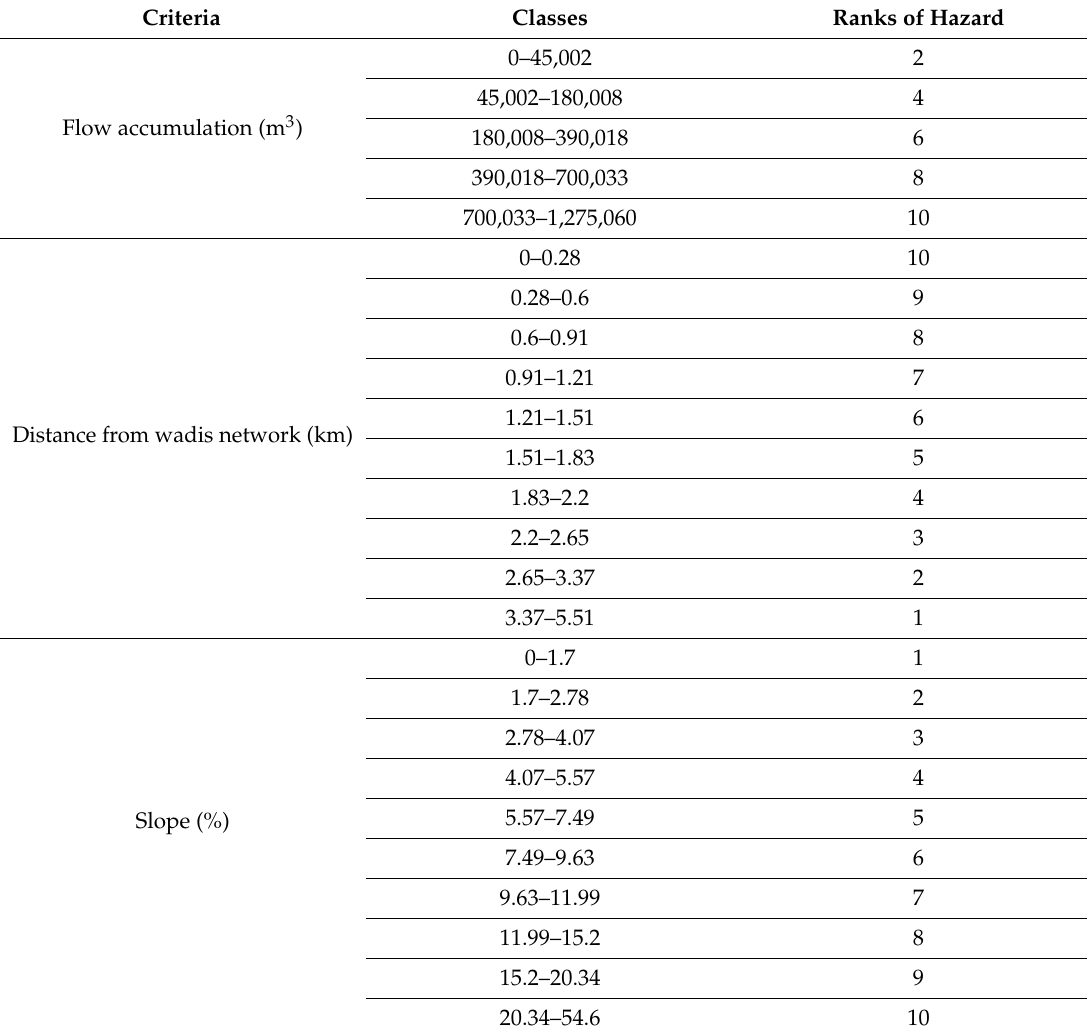
Table 3. The classes of flood hazard for criteria a ff ecting the Al-Shamal train pathway in Al-Qurayyat city in 2020.